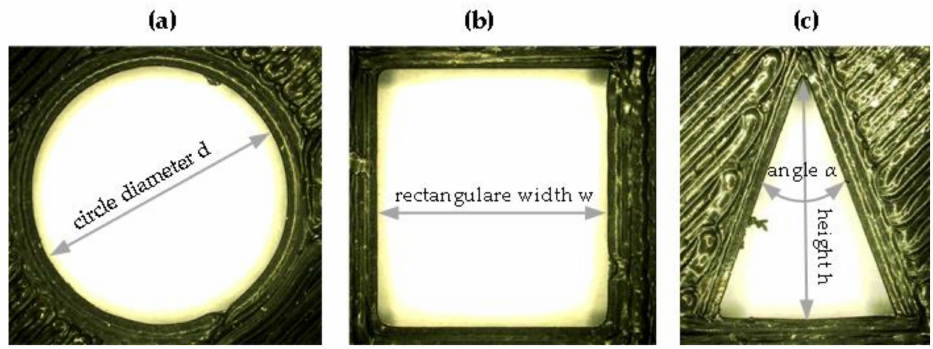
Figure 7. Measurement parameters of the geometric shapes: ( a ) the circle diameter d , ( b ) the rectangle width w and ( c ) the triangle height h and angle α .